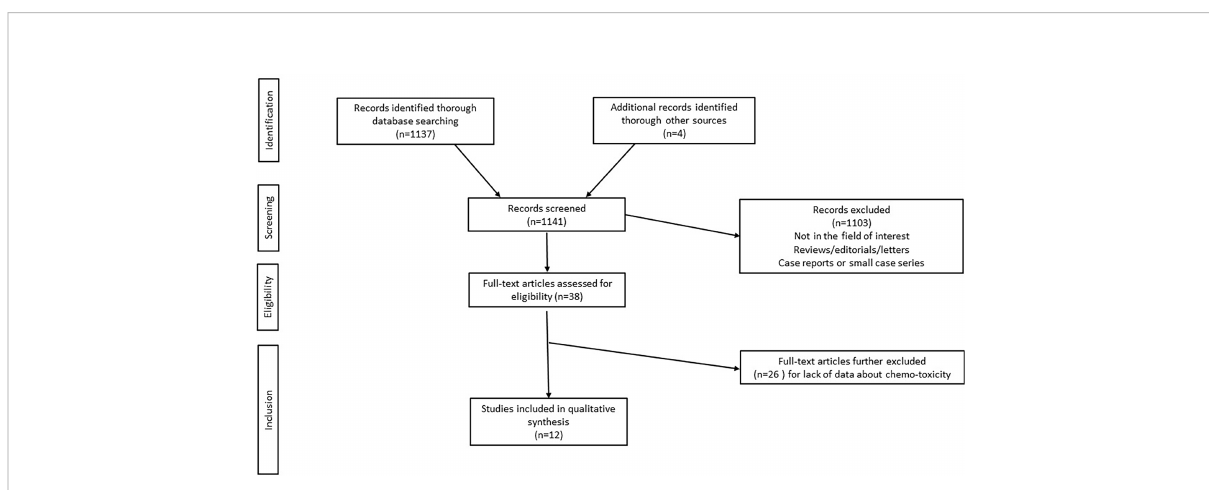
FIGURE 1 Study selection fl